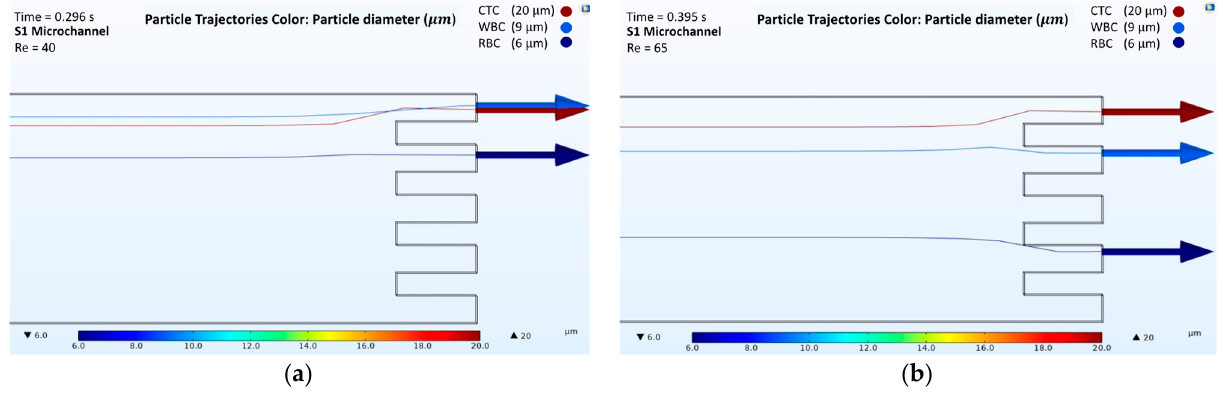
Figure 3. Numerical results of the cell separation study in the S1 microchannel. CTC, WBC, and RBC cells are represented by dark red, light blue, and dark blue colors, respectively: ( a ) Cell distribution at the outlet of the S1 microchannel at a Reynolds number of 40; ( b ) Cell distribution at the outlet of the S1 microchannel at a Reynolds number of 65.